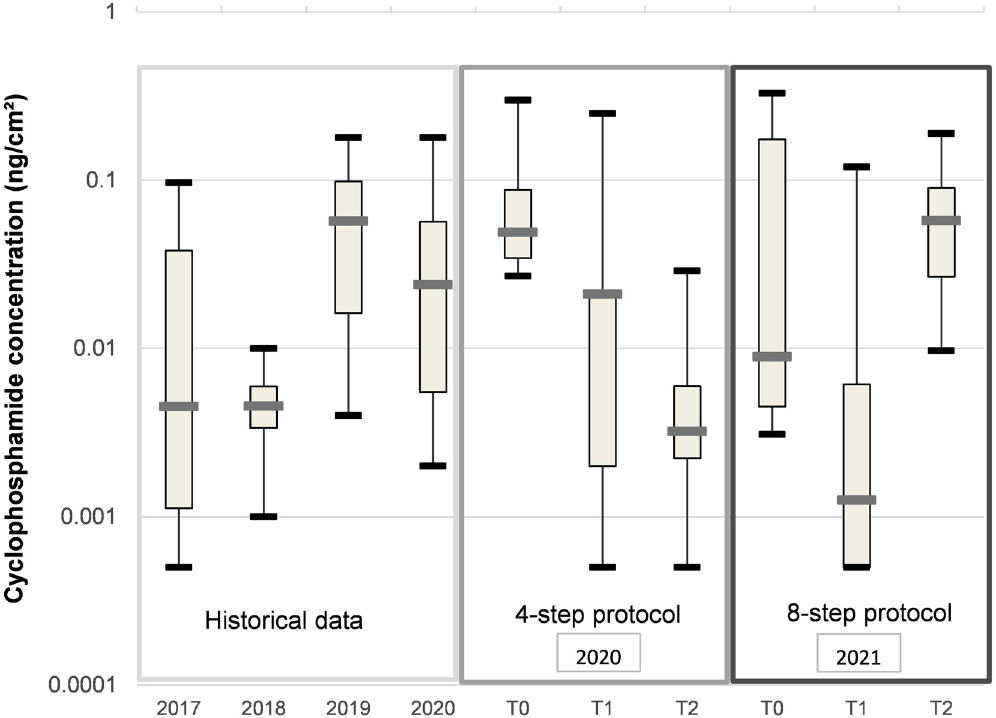
Figure1: Cyclophosphamidecontaminationonbiologicalsafetycabinetfrontgrilles(ng/cm 2 )(n=6samplingsites).2017 – 2020dataobtained fromhistoricalsurfacemonitoringresults.Thefour-stepdecontaminationprotocolwasconductedin2020andtheeight-stepprotocolin2021. Minimum, 25th, 50th, 75th percentile and maximum are shown. Logarithmic scale used. The limit of detection was 0.001 ng/cm 2 .